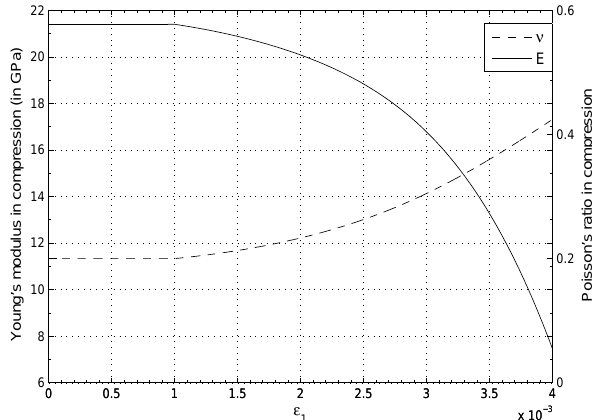
Figure 3. Uniaxial tension. Evolutions of Young’s modulus and Poisson’s ratio.